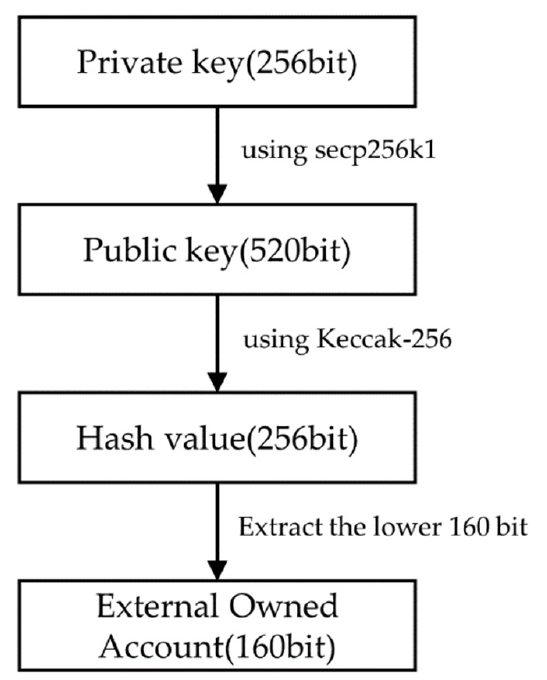
Figure 2. EOA creation process.